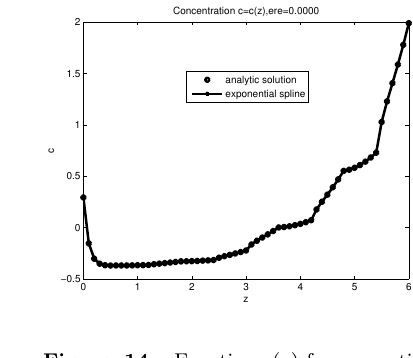
Figure 13. Function c ( z ) for a positive source F(N=10)